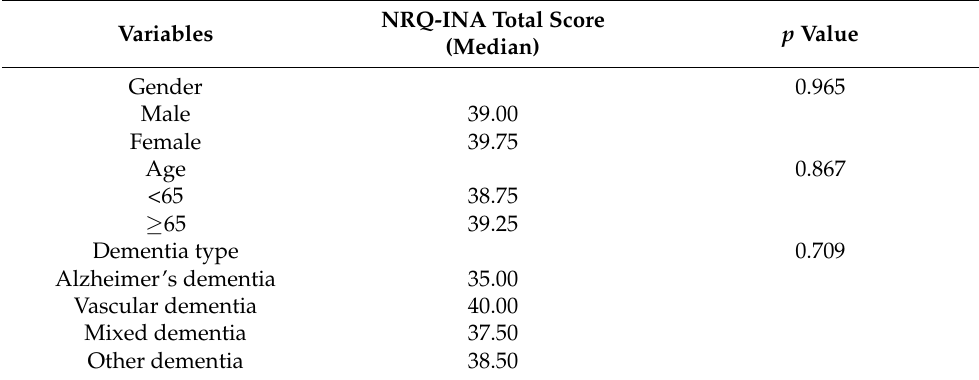
Table 6. The total score of NRQ-INA based on gender, age, and dementia